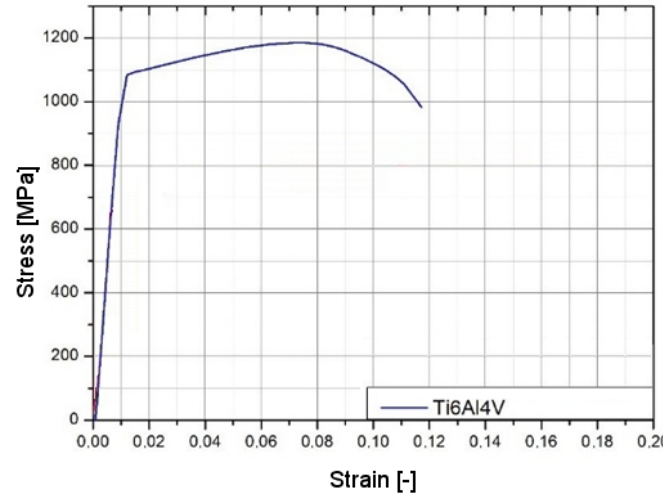
Figure 1. Stress–strain quasi-static characteristic for Ti6Al4V [22].